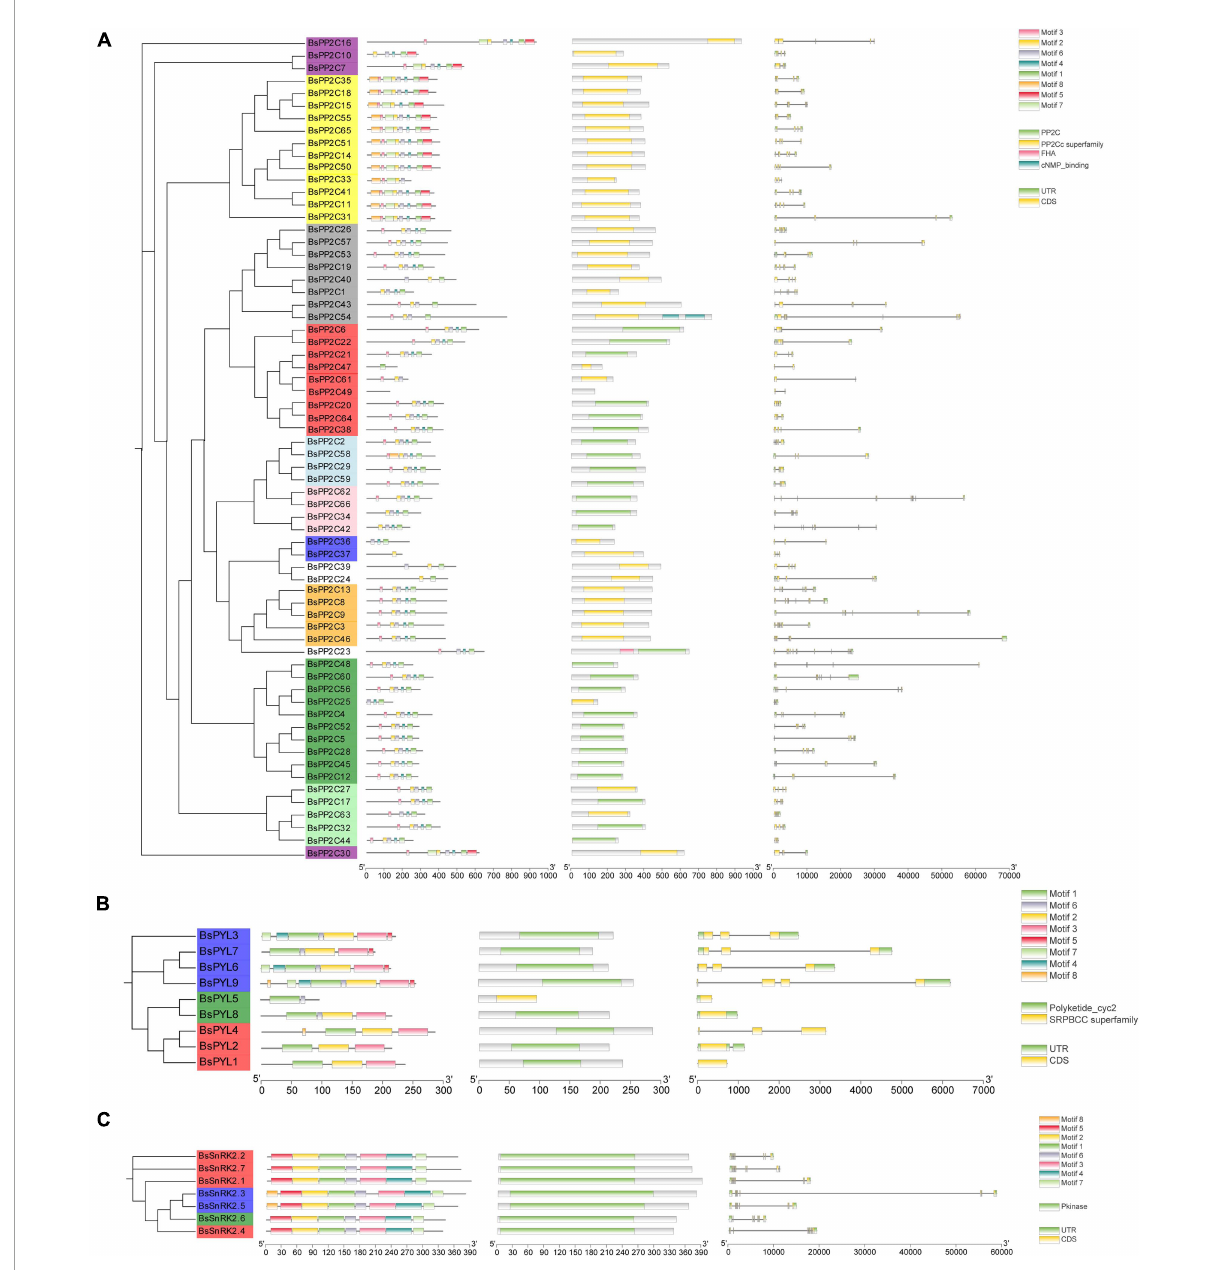
FIGURE2 Phylogenetic trees, motifs, conserved domain and gene structures of BsPP2Cs (A) , BsPYLs (B) , and BsSnRK2s (C) gene families. For the phylogenetic trees, different leaf background colors indicate various subgroups. For the motifs, different colored boxes indicate various conserved motifs. For the conserved domain, colored boxes indicate different conserved domain. For the gene structure, green boxes, gray lines, and yellow boxes represent exons, introns, and UTRs, respectively. The results were displayed using TB tools v